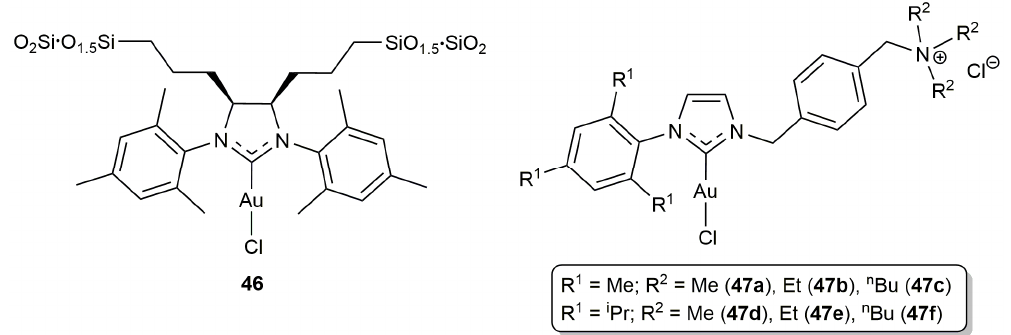
Figure 3. Structure of the NHC-gold(I) complexes 46 and 47a–f .